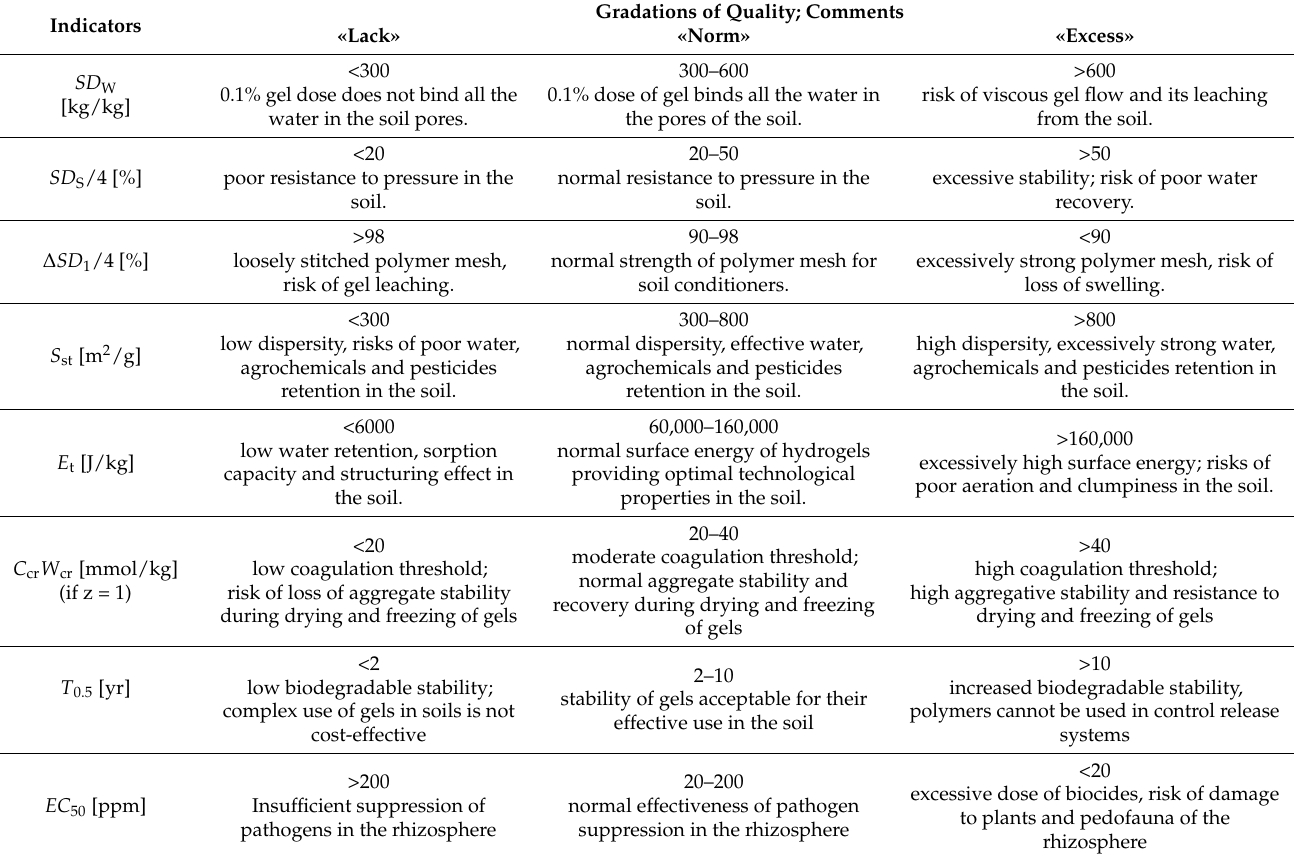
Table 2. Guidelines for the main quality indicators of gel-forming soil